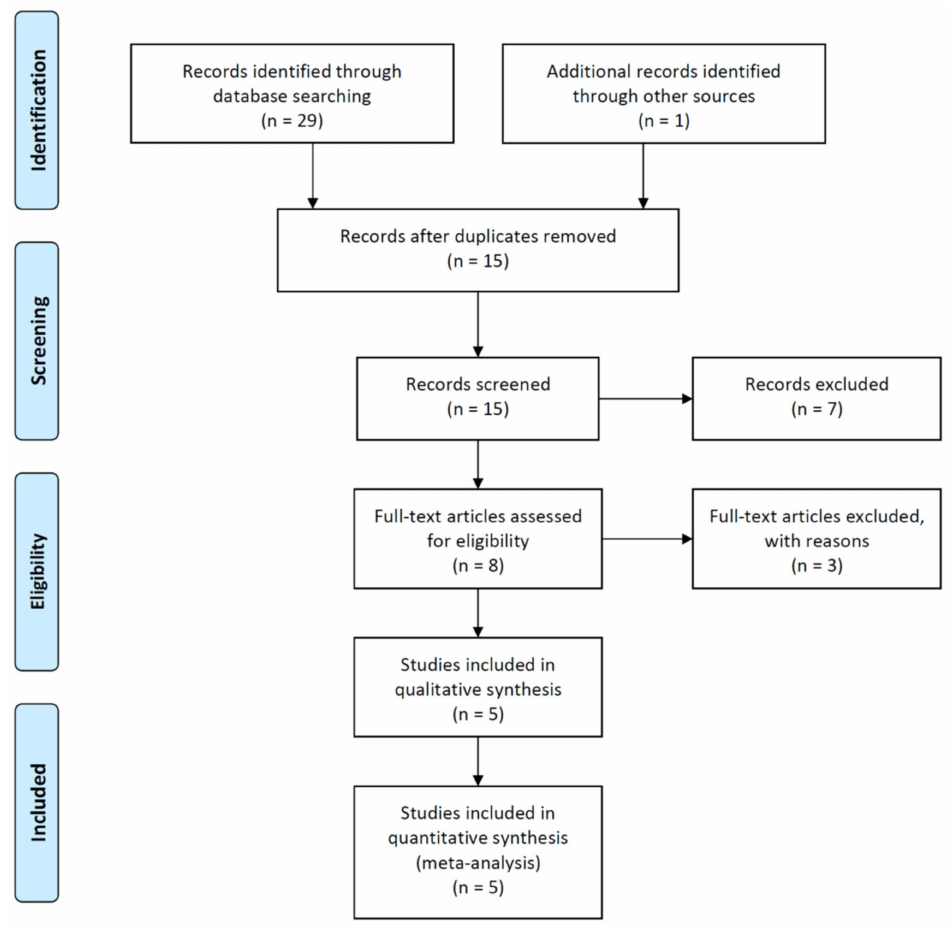
Figure 1. PRISMA flow